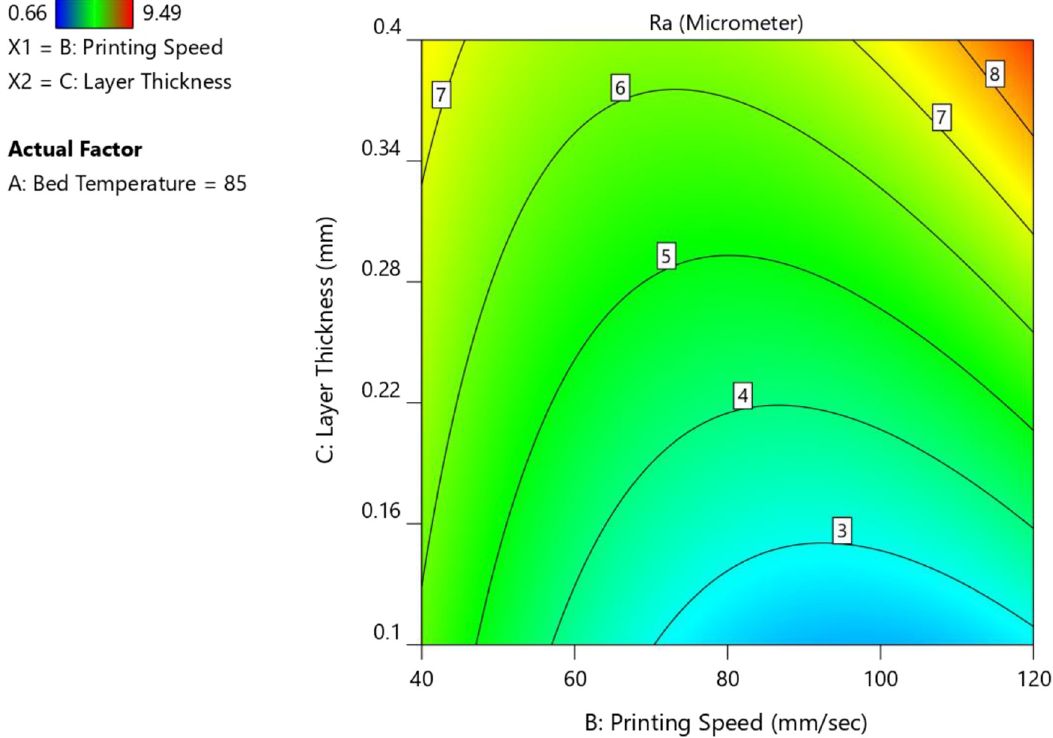
Fig. 13. Interaction plot between printing speed (B) and layer thickness